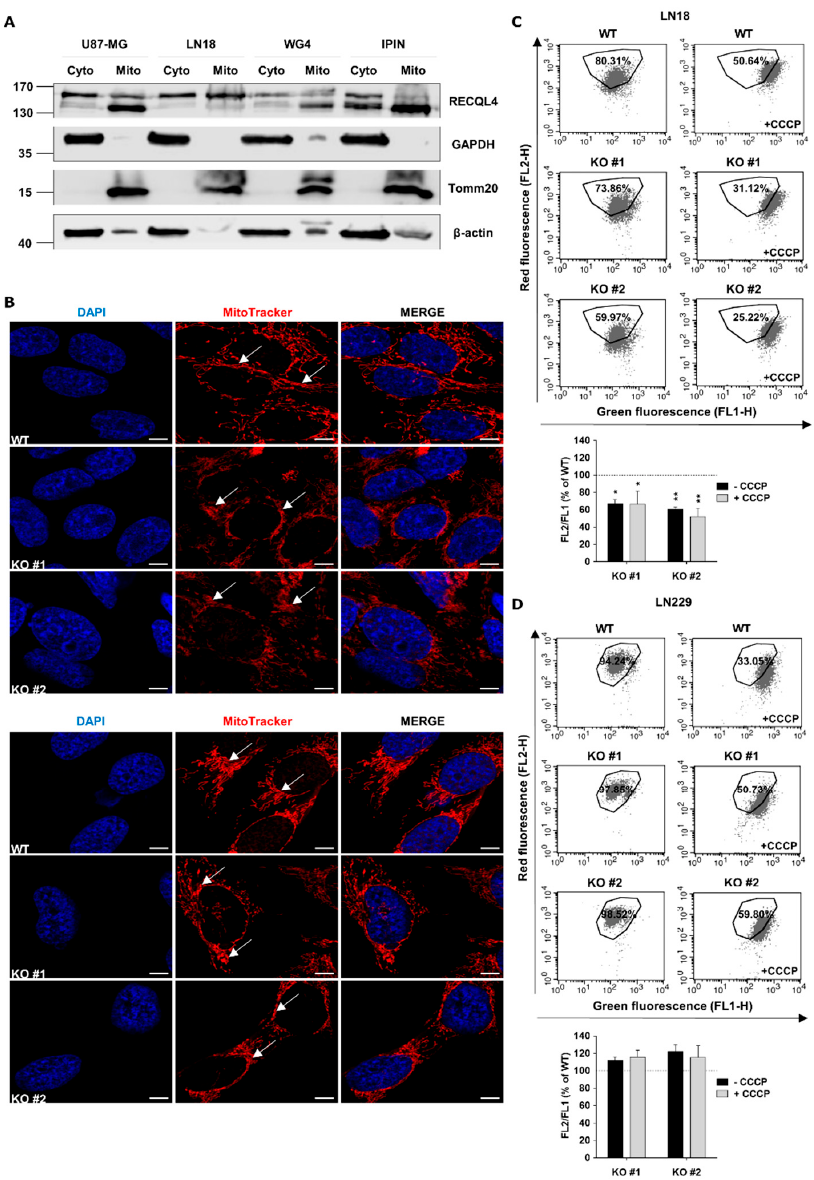
Figure 5. RECQL4 depletion affects morphology and functions of mitochondrial network in glioblastoma cells. ( A ) Representative immunoblots showing subcellular distribution of RECQL4 in cytosolic (Cyto) and mitochondrial (Mito) fractions of human U87-MG, LN18 and primary WG4, IPIN cultures of glioblastoma cells. Expression of GAPDH and Tomm20 was used as a loading control and markers for cytosolic and mitochondrial fractions, respectively. ( B ) Representative images of mitochondrial morphology and network organisation in LN18 (upper panel) and LN229 (bottom panel) cells analysed by confocal microscopy. WT and RECQL4 KO cells were stained for mitochondria (MitoTracker, red) and nuclei (DAPI, blue). Scale bar represents 5 µm. ( C ) Representative histograms and quantification of mitochondrial transmembrane potential changes in WT and KO LN18 cells. The cells were stained with JC-1 probe and analysed by FACS. CCCP was used as a positive control. The results are shown as red/ green fluorescence intensity ratio (relative FL-2/ FL-1) in RECQL4 KO cells normalized to WT cells, and represent means ± SEM ( n = 3). Statistical significance was determined by RM two-way ANOVA, with followed by Tukey’s HSD post hoc test. P values were considered as significant when * p < 0.05, ** p < 0.01. ( D ) Representative histograms and quantification of mitochondrial transmembrane potential changes in WT and RECQL KO LN229 cells.